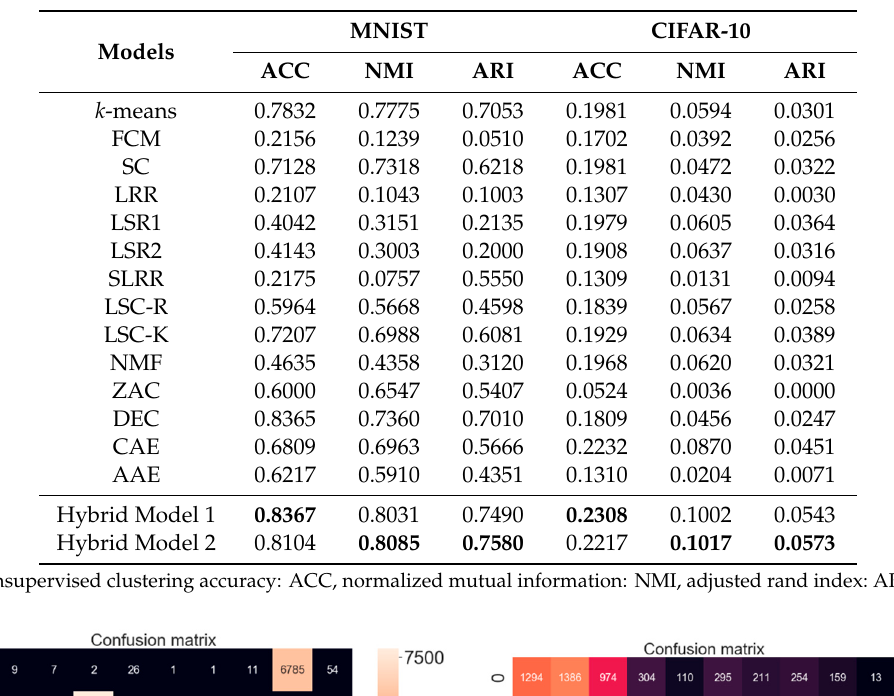
Table 2. The performance comparison between various clustering methods.